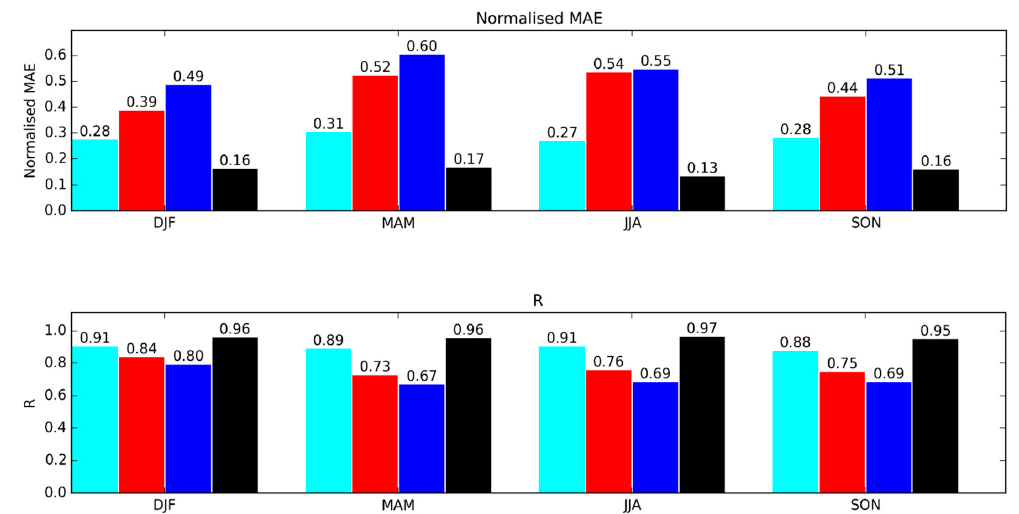
Figure 9. Point-based comparison categorised by seasons from January 2001 to December 2018 using station gauges as truth. Mean average error (MAE), normalised MAE, and R are displayed.